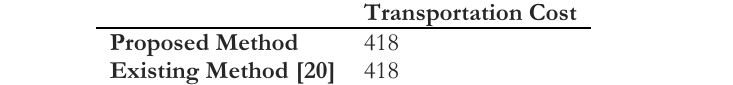
Table 11. Comparison of proposed method with existing method of example